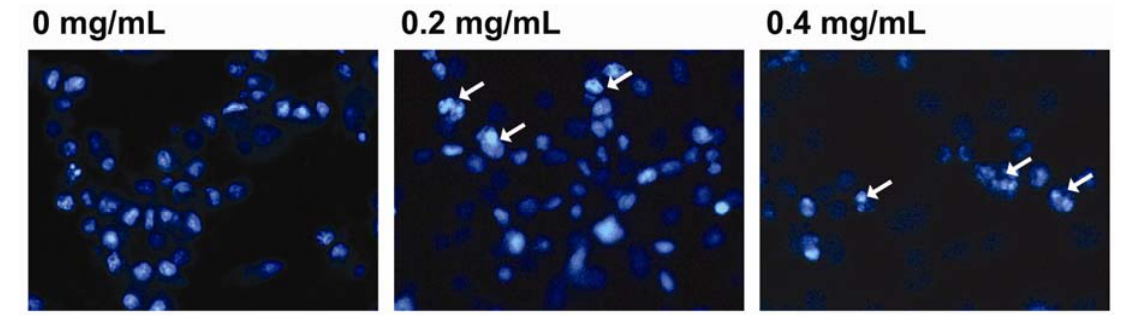
Figure 3. Effect of the essential oil of Cryptomeria japonica on determination of morphological changes in KB cells. KB cells were treated with 0.2 and 0.4 mg/mL of the essential oil for 12 h. Following the treatment, cells were collected for three kinds of experiments for apoptosis induction. The morphologic change was assessed by fluorescence microscopy after staining with Hoechst 33258. The apoptotic cells are indicated with arrows. Normal nuclear morphology is observed in untreated cells. In contrast, small, fragmented, and condensed nuclei with typical apoptotic morphology were observed in treated cells.